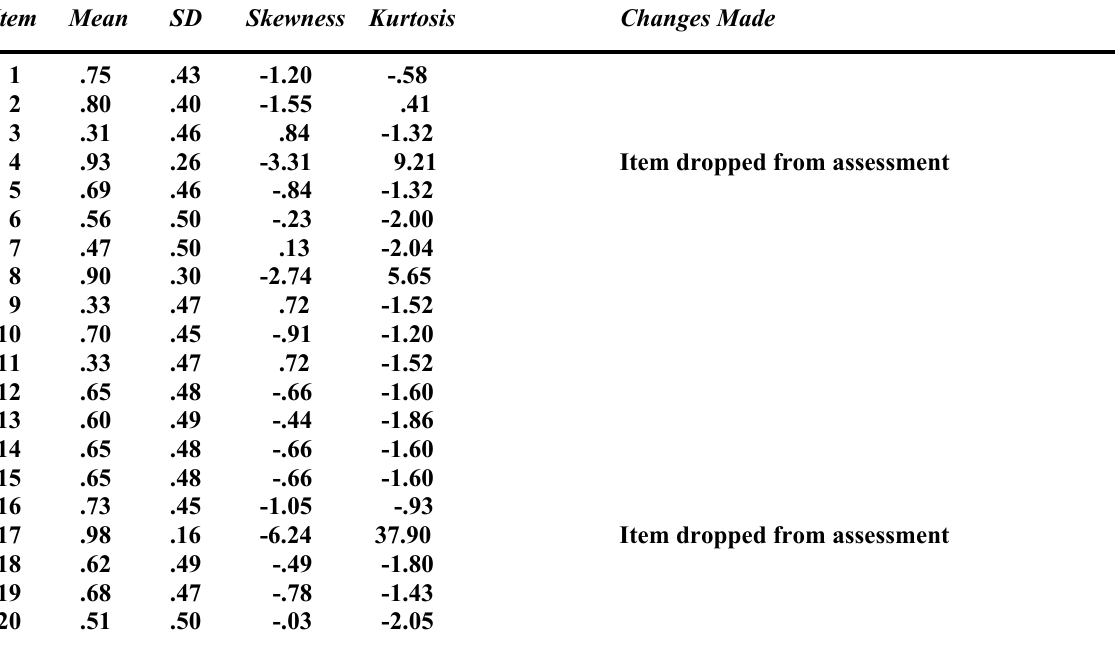
Descriptive Statistics of the 20-item